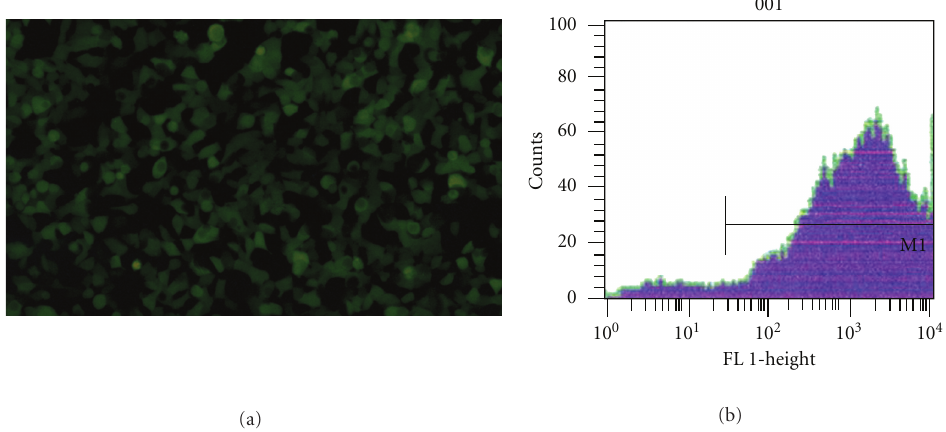
Figure 2: HepG2 cell transfection with TPG for 48 h. (a) The GFP expression was observed under a fluorescence microscope ( × 100); (b) The transfection rate was detected by flow cytometry.